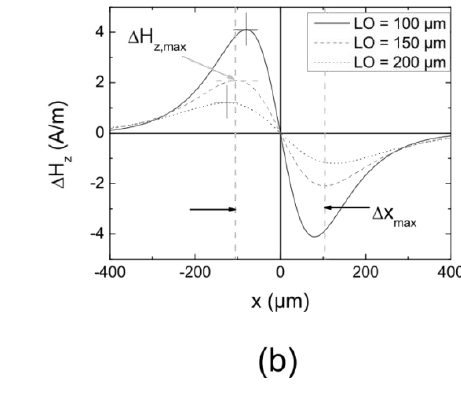
Figure 4. ( a ) Simulated MFL as grayscale representation for a crack with dimensions t = 50 µm, w = 2 µm and l = 500 µm; ( b ) Line scans across the centre of the crack (black line in ( a )). For different LO the two parameters Δ H The crosses represent the x -position, at which Δ H